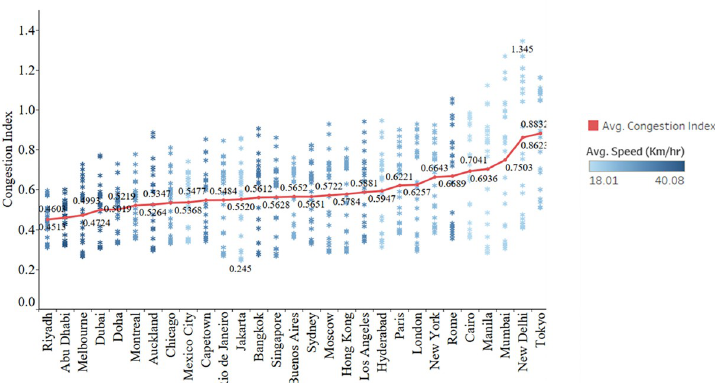
Fig 1. Estimated CI and observed average speed. CI is a relative measure that compares the current traffic speed to the free-flow speed, a threshold value that represents the beginning of the delay. The blue dot points represent the estimated CI for each hour of a day. The red dot points represent the average estimated CI per day. A color gradient is used to show the variation in average speed of the